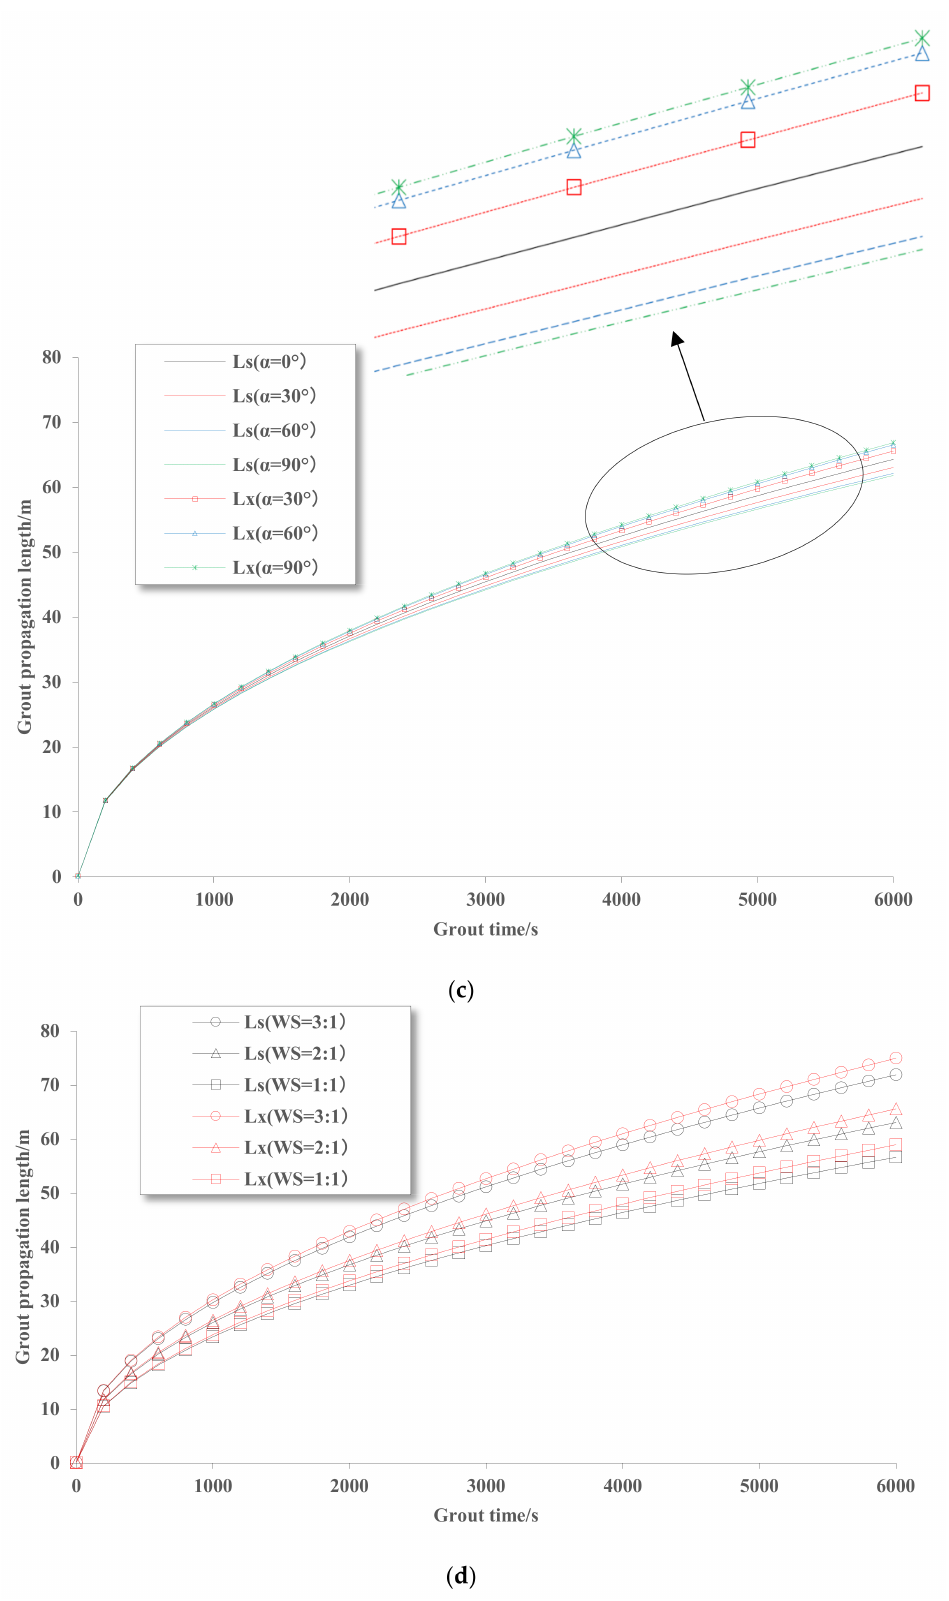
Figure 3. Variation curve of grout propagation length with duration under various influencing factors. ( a ) Grout pressure, ( b ) width of fracture, ( c ) angle between fracture and horizontal hole, ( d ) water-cement